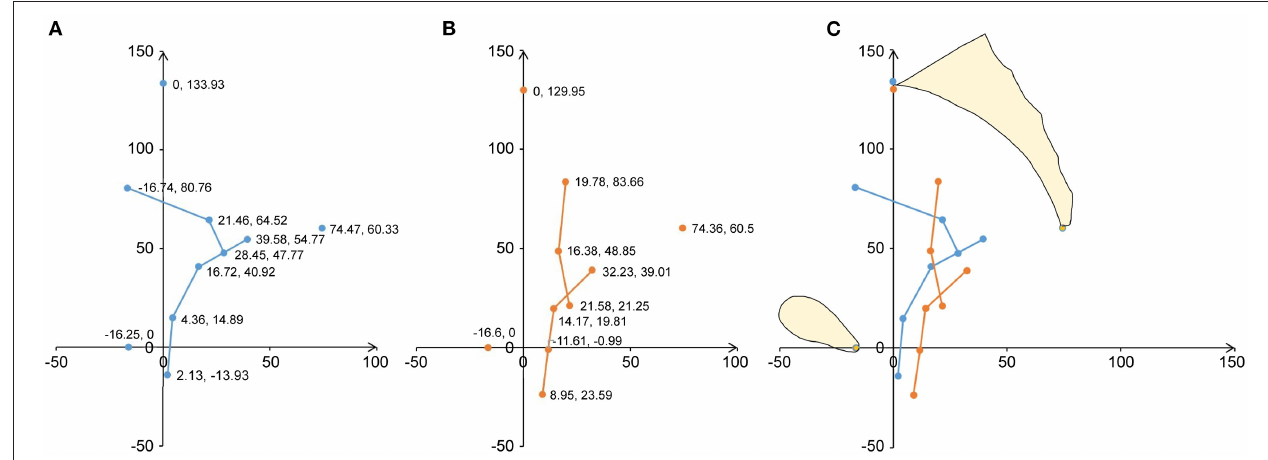
FIGURE 3 | Analysis of the average shape and position of the geometric structure of the uterus and vagina on the median sagittal plane. A mid-sagittal shape and the mean shape of the uterine axis and vaginal axis are shown in terms of the local pelvic inclination correction system (PICS) coordinates. (A) The geometric results of 57 participants without prolapse are shown. The blue dots show the location and coordinate values of the average coordinates of the uterine and vaginal anatomical marks. The blue line indicates the average shape. (B) The geometric results of 81 patients with prolapse are shown. The orange dots show the position and coordinate values of the average coordinates of the uterine and vaginal anatomical marks. The orange line indicates the average shape. (C) The average coordinate positions and shapes of the uterine and vaginal anatomical markers for the prolapse and non-prolapse groups are shown. Orange is the average shape of the prolapse group and blue is the average shape of the non-prolapse